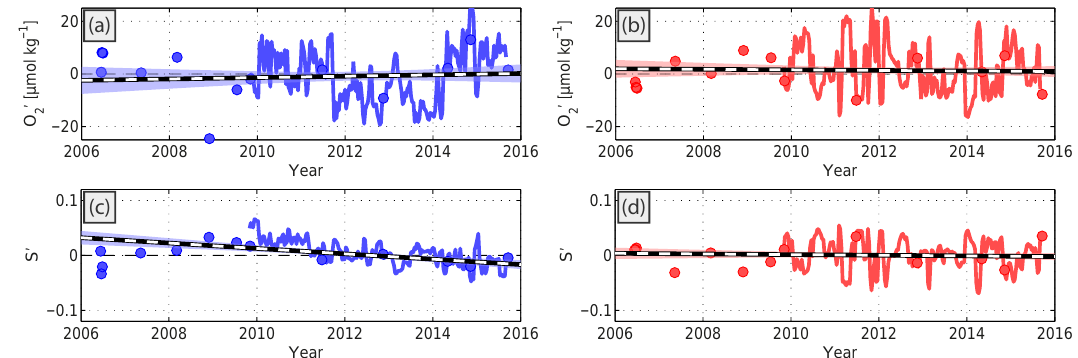
Figure 5. Oxygen ( a and b ) and salinity ( c and d ) anomaly time series from moored (solid line) and shipboard (dots) observa- tions at 5 ◦ N, 23 ◦ W. Panels (a) and (c) show averages between 200 and 400m. Panels (b) and (d) show averages between 500 and 800m. Black dashed lines show respective trends from combined moored and shipboard observations: (a) 2.6 ± 7.8µmolkg − 1 decade − 1 ,